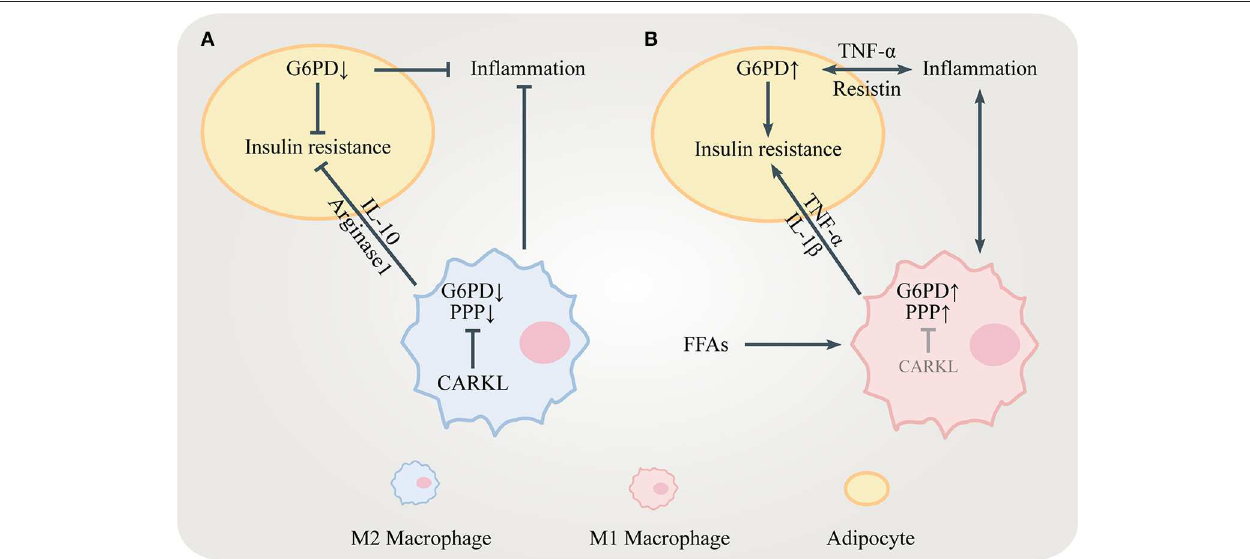
FIGURE 2 | The role of the PPP in insulin resistance. (A) CARKL is highly expressed in M2 macrophages, limiting the PPP flux by inhibiting G6PD. M2 macrophages release anti-inflammatory mediators including IL-10 and arginase 1 to maintain insulin sensitivity. Decreased G6PD in adipocytes suppresses inflammation and